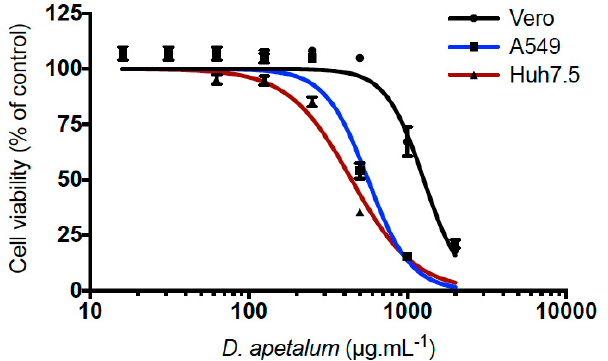
Figure 1. The cytotoxicity of D. apetalum extract on di ff erent cell lines. Vero, A549 and Huh7.5 cell lines were incubated with di ff erent concentrations of D. apetalum extract for 72 h. A 3-[4,5-dimethylthiazol-2-yl]-2,5- diphenyltetrazolium bromide (MTT) assay was performed to evaluate cell viability. Results are means ± SD of four independent experiments and are expressed as relative values compared to untreated cells.